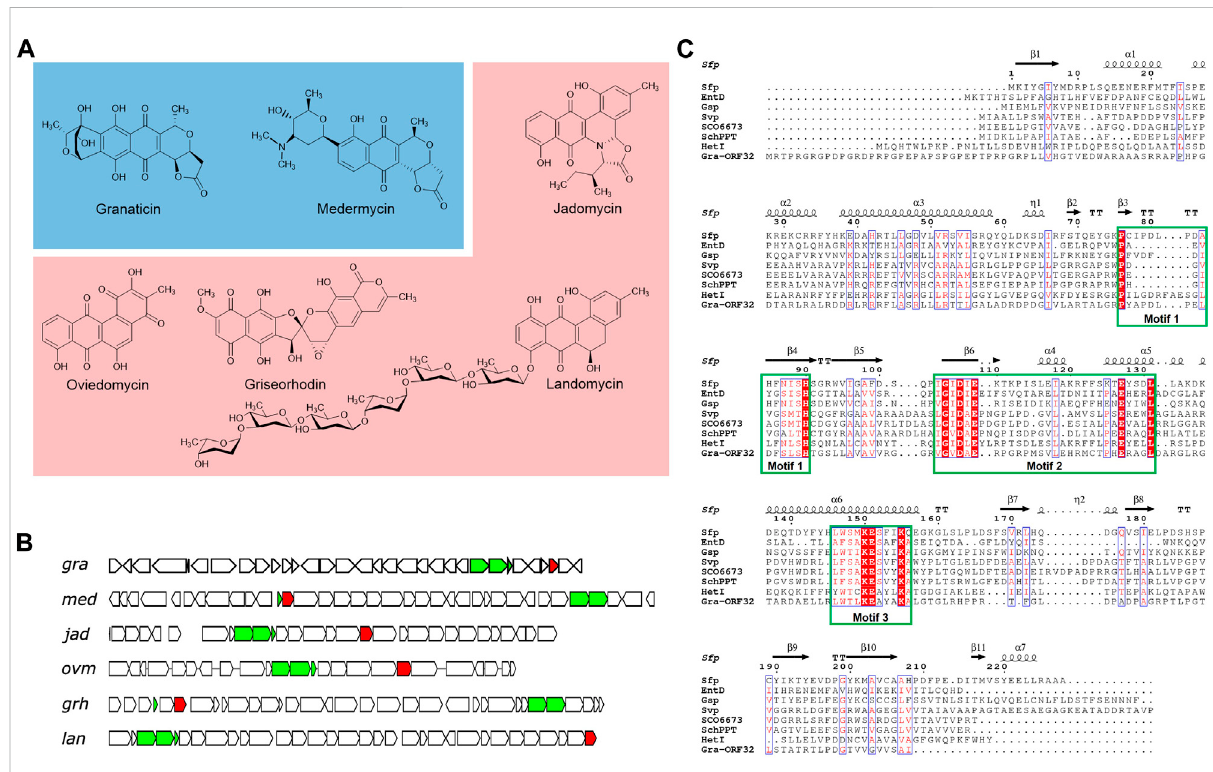
FIGURE 1 Selected type II polyketides and their biosynthetic gene clusters harboring an in-cluster phosphopantetheinyl transferase (PPTase) gene. (A) Representative type II polyketides. Pyranonaphthoquinone members are colored in blue background and angular polyketides in pink. (B) Organizations of the biosynthetic gene clusters of the selected type II polyketides, highlighting the minimal PKS and the PPTase genes. The minimal PKS genes are colored in green and the PPTase genes in red. (C) Sequence alignment of Gra-ORF32 with Sfp and other Sfp-type PPTases. The surfactin PPTase Sfp is from Bacillus subtilis (CAA44858.1) and its crystal structure (PDB: 1QR0) was used to generate the ESPript output picture. Other PPTases, E. coli EntD (NP_415115.2), Brevibacillus brevis Gsp (CAA53988.1), S. verticillus ATCC15003 Svp (AAG43513.1), S. coelicolor A3